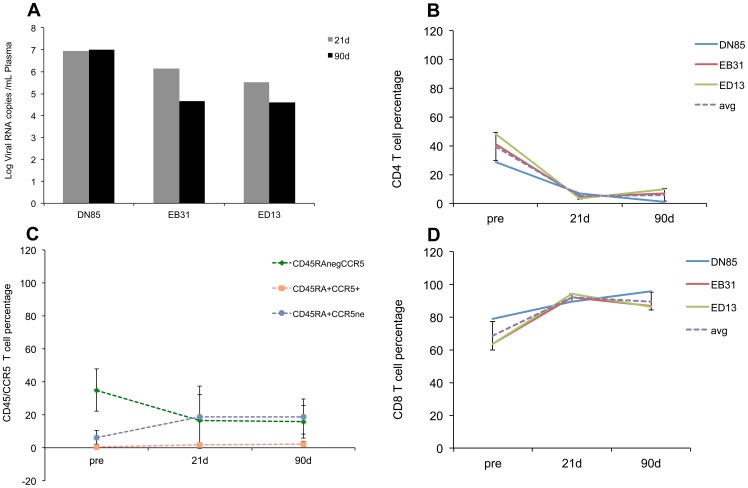
SIV infection results in elevated plasma viremia and rapid depletion of mucosal CD4+ T cells.Plasma viral loads (A) and changes in mucosal CD4+ T cells (B) “memory” CD4+ T cells (CD45RAneg, CCR5+) (C), and mucosal CD8+ T cells (D) in three Indian origin rhesus macaques at 21 and 90 days after intravenous infection with SIVmac251. Changes in CD45RA+/CCR5- populations at the 21 and 90d timepoints were not statistically significant (p>0.05).